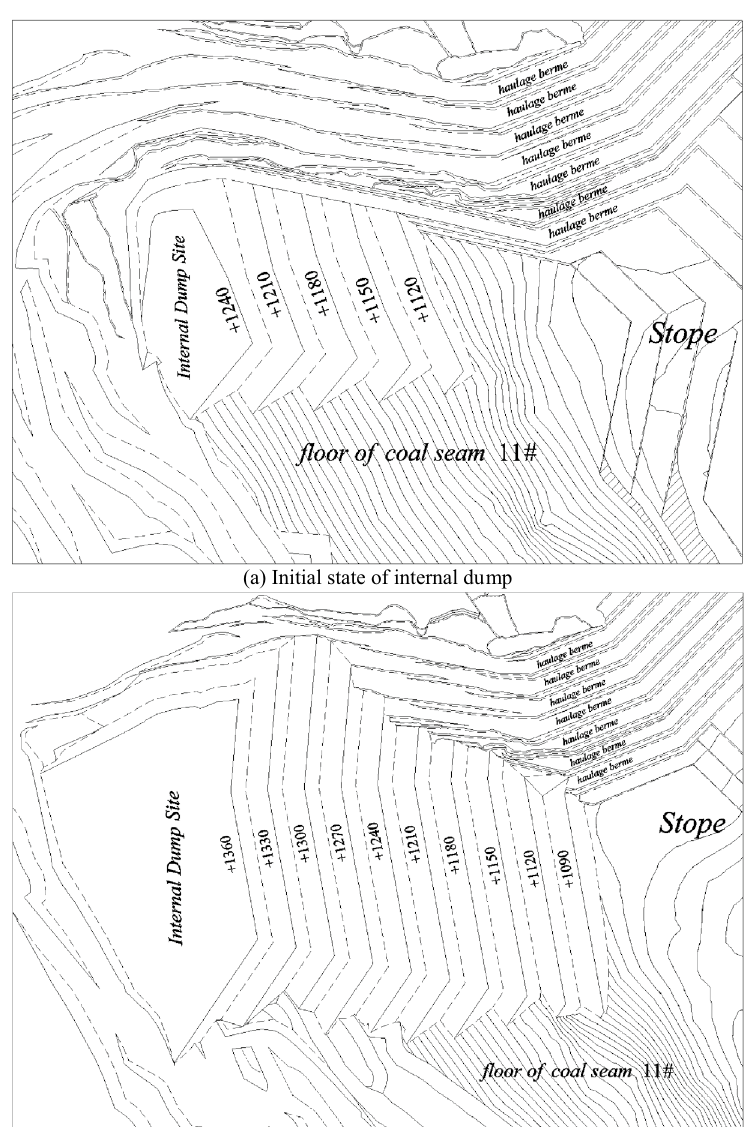
Fig. 13 Diagram of internal dump construction and devel- opment procedure in Luzigou anticline